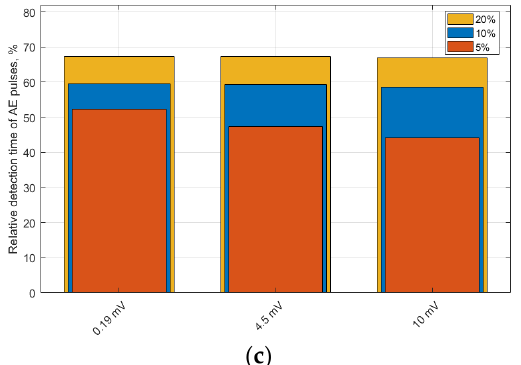
Figure 16. Relative detection time for the AE pulses comprising of 5, 10, and 20% of all the reliably detected pulses in each of the laboratory experiments (uniaxial tension of the woven laminate sample cut along the warp and weft directions ( a ) and the unidirectional CFRP sample cut along the fiber direction ( b ) at various background signal intensities).